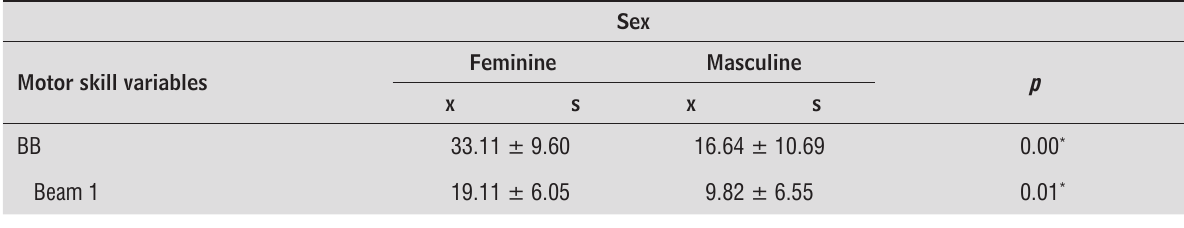
Table 2 - Scores in the battery of KTK tests of girls and boys born